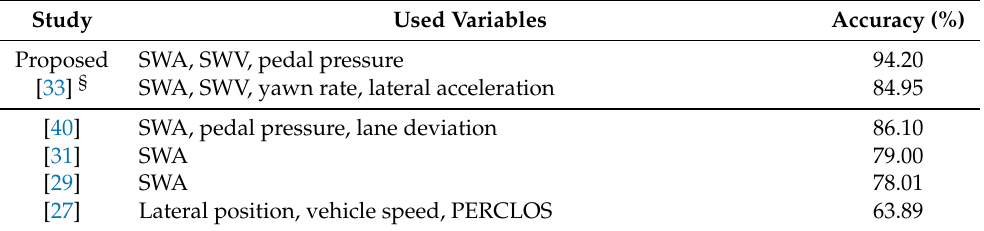
Table 10. Performance comparison and used variables with previous